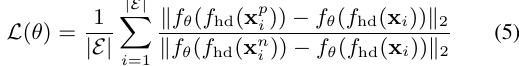
Figure 2. Siamese network architecture. Local features of an anchor point x i , positive example x p extracted and fed to the fully connected Siamese neural network (yellow squares). The output layer (blue squares) represents the intermediate representation used for feature matching in the online stage. All branches of the network share all the